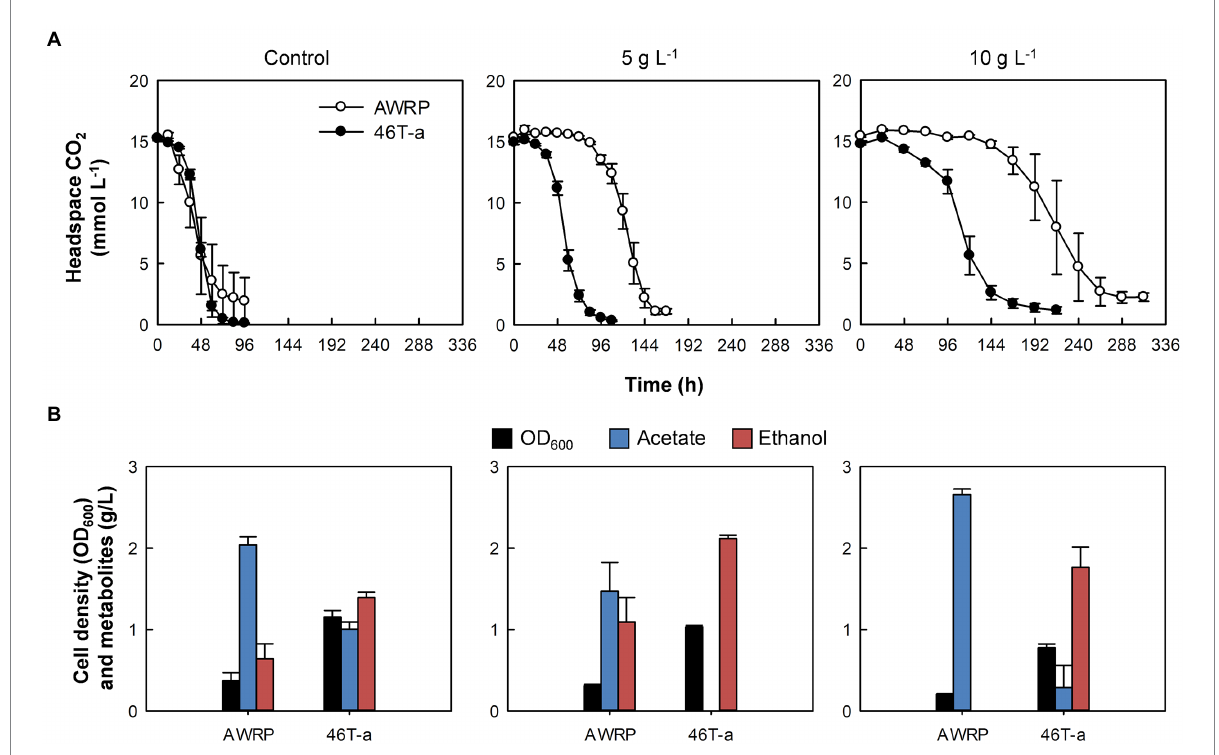
FIGURE 1 Comparison of wild-type AWRP and 46 T-a in the absence or presence of exogenous acetate. (A) Headspace CO 2 . (B) Cell mass and metabolites produced. Samples were taken with the last sampling of CO 2 (see panel A ). Acetate titers were expressed as net values obtained by subtracting the initial value from the final value for each bottle. Cultivation of each strain was conducted in triplicate and average values are shown. Error bars represent one standard